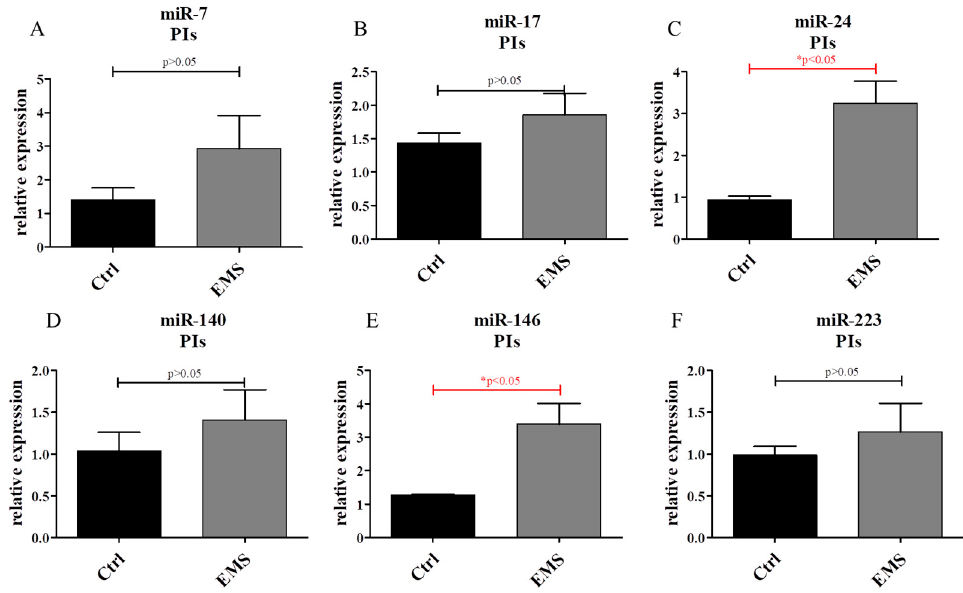
Figure 11. miR expression in PIs. Using PCR, the expression of the following miRNAs was investigated: miR-7 ( A ); miR-17 ( B ); miR-24 ( C ); miR-140 ( D ); miR-146 ( E ); and miR-223 ( F ). Results expressed as mean ± S.D. * p < 0.05.